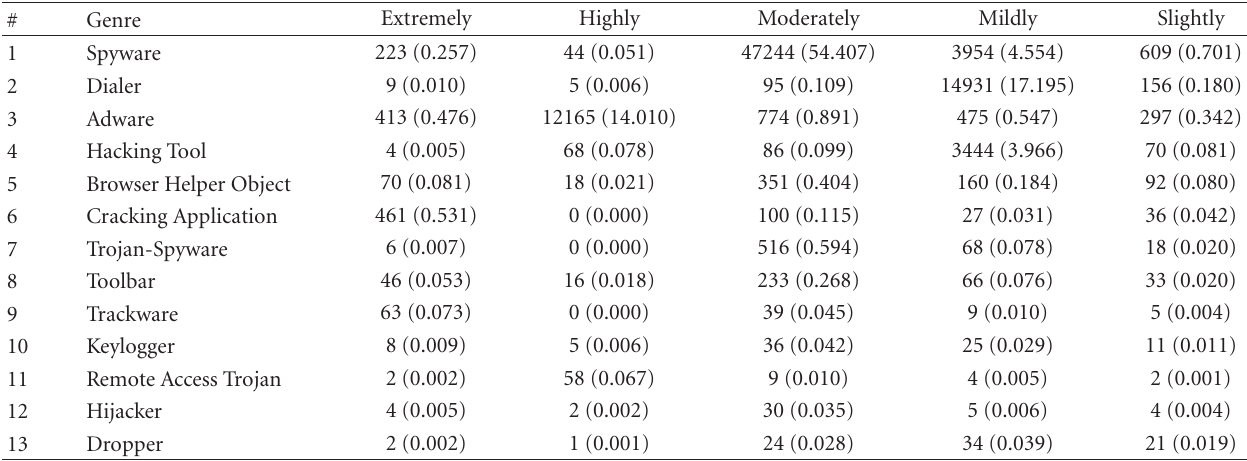
Table 9: Risk levels of grayware assigned by the proposed framework.